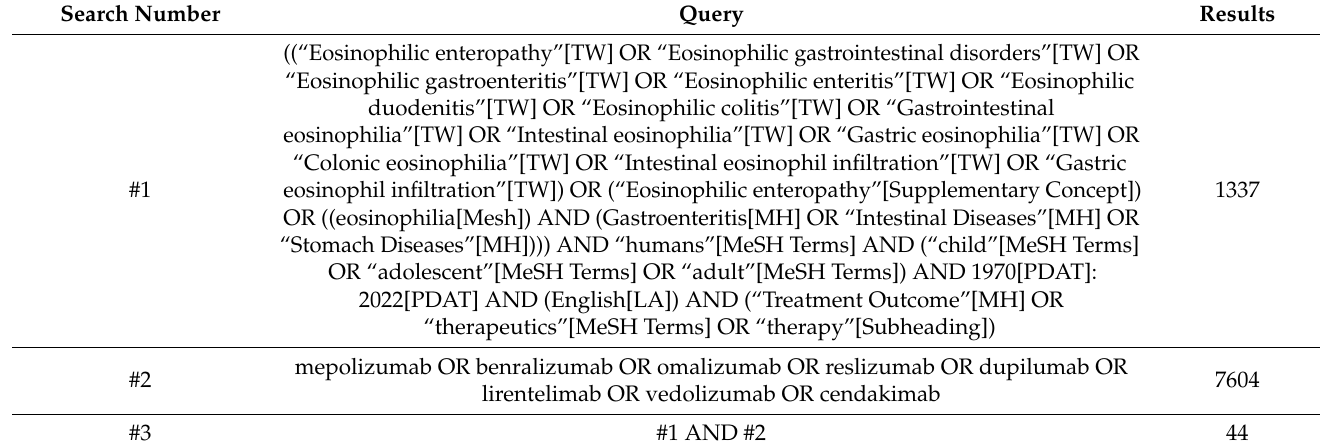
Table 1. Search strategy used for the systematic reviews conducted in this study (PubMed).